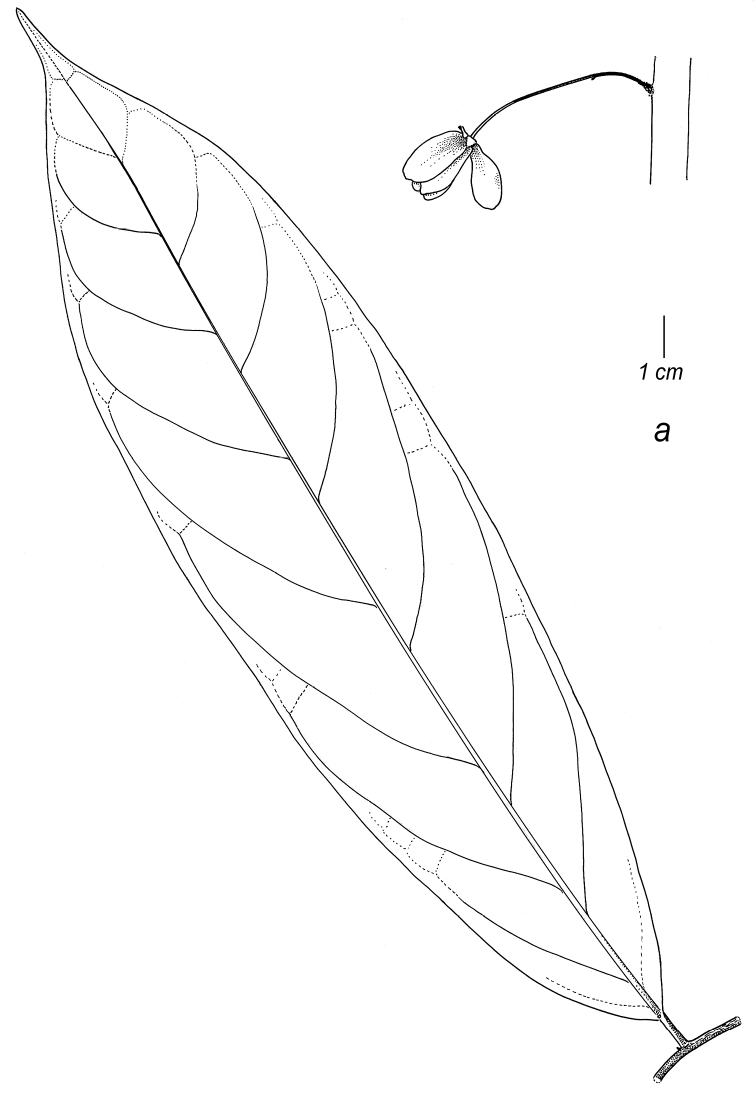
Cremastospermastenophyllum Pirie. a flower and leaf (Knapp & Mallet 6159).